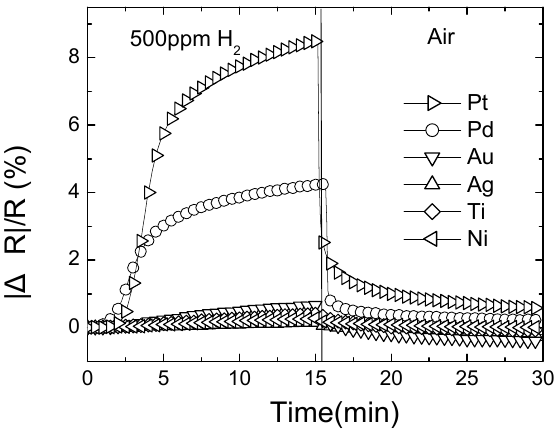
to 500 ppm of H in air as time proceeds. 2 2 . 2